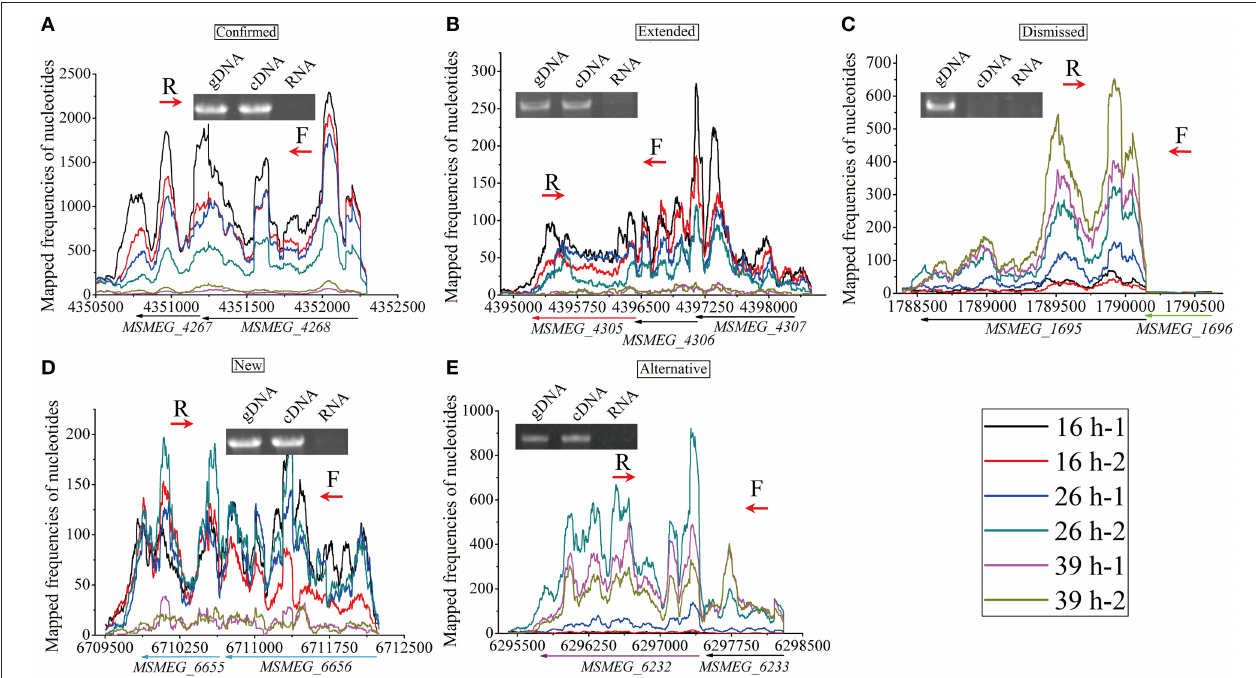
FIGURE 9 | Examples of the five groups of identified operon. The RT-PCR forward (F) and reverse (R) primers are indicated in red arrows. (A) Confirmed, DOOR annotated MSMEG_4268 and MSMEG_4267 as an operon, our RNA-seq data and RT-PCR experiment also indicate this. (B) Extended, DOOR annotated MSMEG_4307 and MSMEG_4306 as an operon, without MSMEG_4305 (in red arrow); however, our RNA-seq data and RT-PCR experiment found that the transcription was extended to MSMEG_4305 . (C) Dismissed, DOOR annotated MSMEG_1696 to MSMEG_1695 (in green arrow) as an operon, however, our RNA-seq data and RT-PCR experiment indicated that MSMEG_1696 was dismissed from transcription. (D) New, our RNA-seq data identified new operons not found by DOOR, which was also indicated by RT-PCR. (E) Alternative, MSMEG_6233 and MSMEG_6232 (in purple arrow) were found to be co-transcribed; and MSMEG_6232 seems to be alternatively transcribed from its own